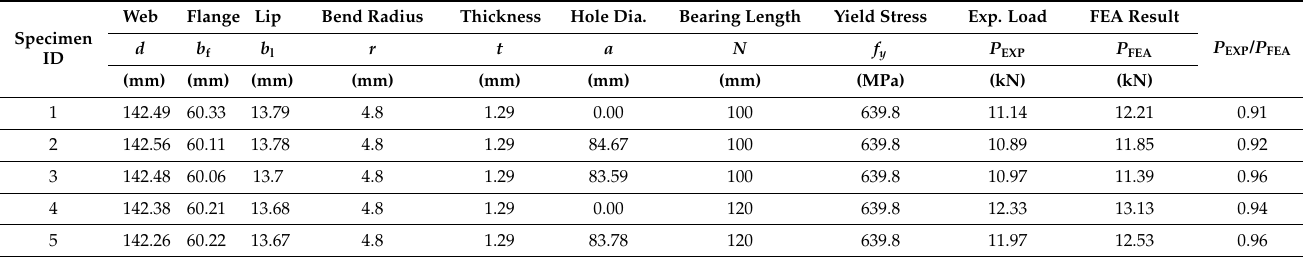
Table 2. Comparison of experimental results with FEA results for sections with fastened